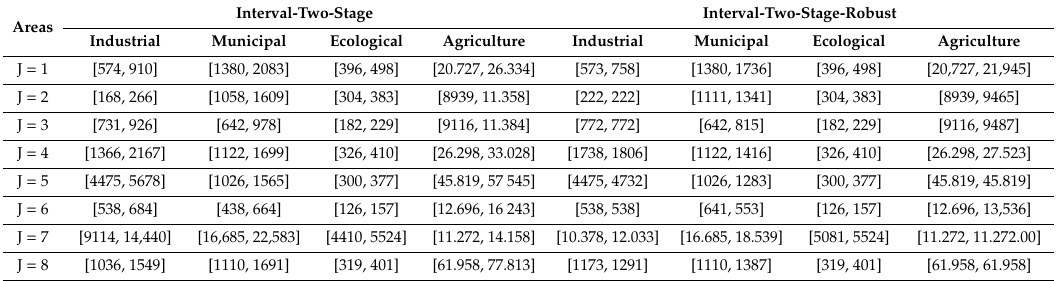
Table 6. Water resources allocation of interval two-stage stochastic programming (ITSP) model and interval two-stage robust (ITSR) model in the first planning period (10 4 m 3 /